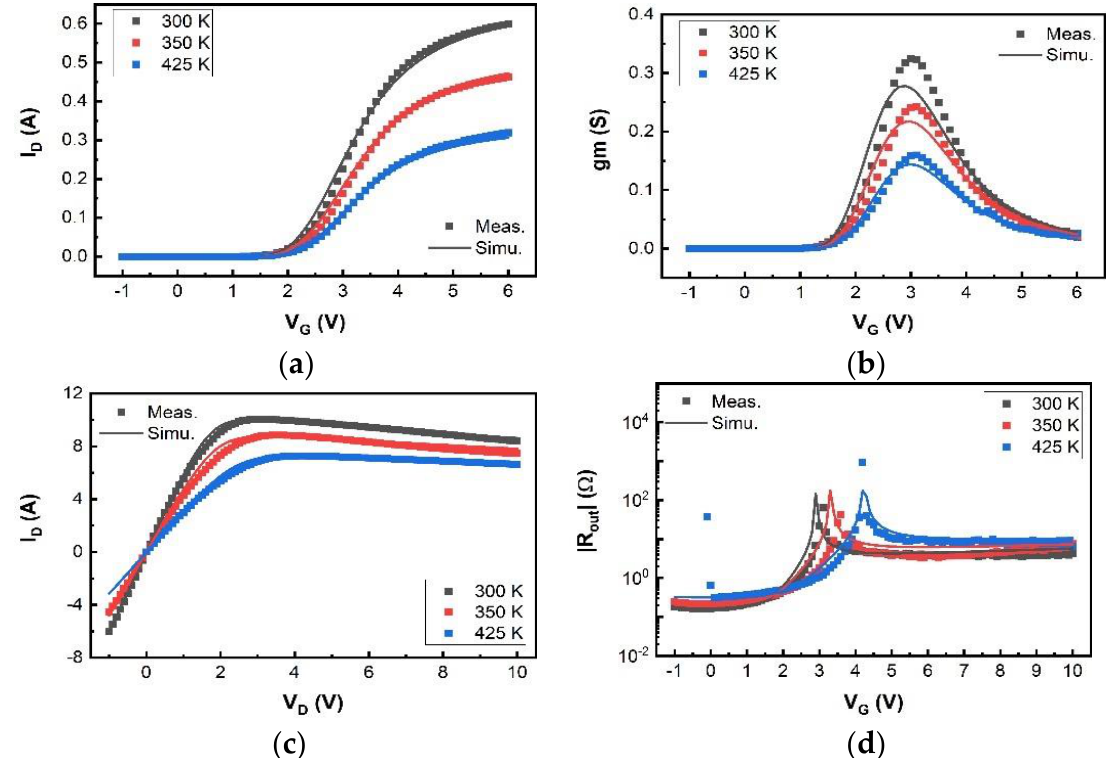
Figure 6. Measurement data (dots) and simulation data (line) at different temperatures. ( a ) Transfer characteristics with V D = 0.1 V; ( b ) transconductance resistance characteristics with V D = 0.1 V; ( c ) output characteristics with V G = 7 V; ( d ) output resistance characteristics with V G = 7 V.